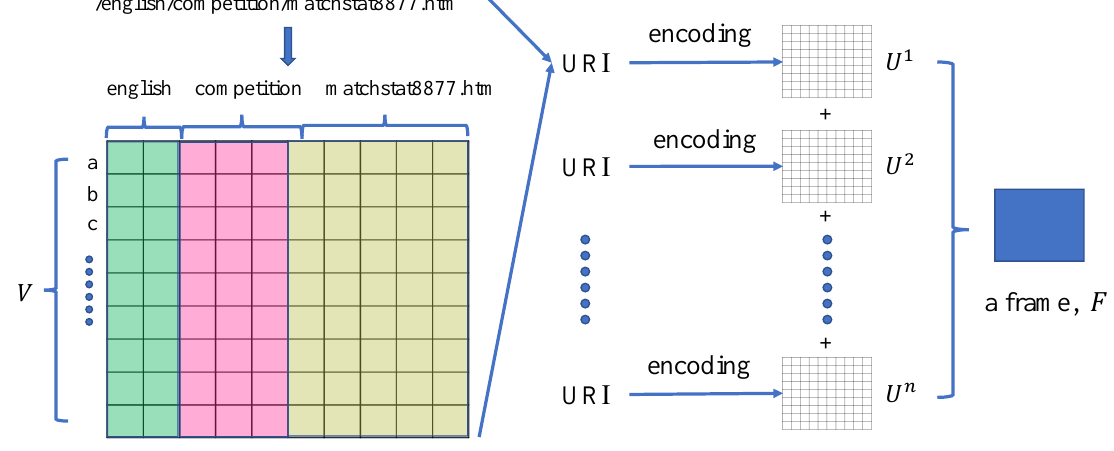
Figure 2. The encoding strategy of